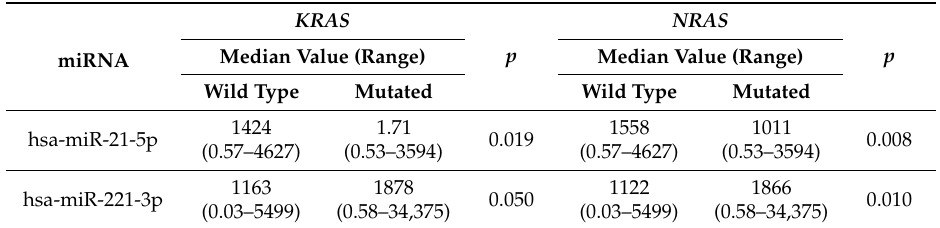
Table 3. miRNAs significantly correlated with RAS